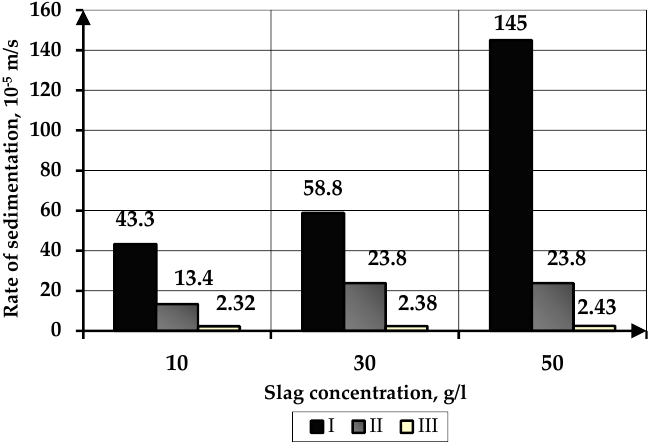
Figure 7. Dependence of the particle sedimentation rate on the concentration of ultrafine slag without ultrasonic treatment.